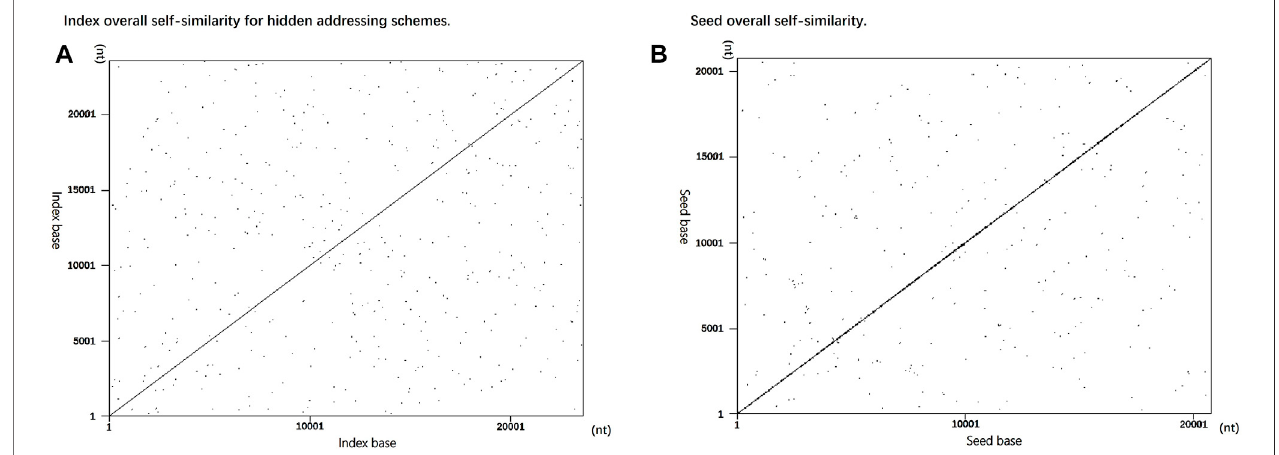
FIGURE4| Self-similaritycomparisonbetweenencodingindices. (A) Utilizedatainsteadofoverallself-similaritybetweenindices. (B) Overallself-similaritybetween seeds used for splicing sequences in fountain coding experiments.